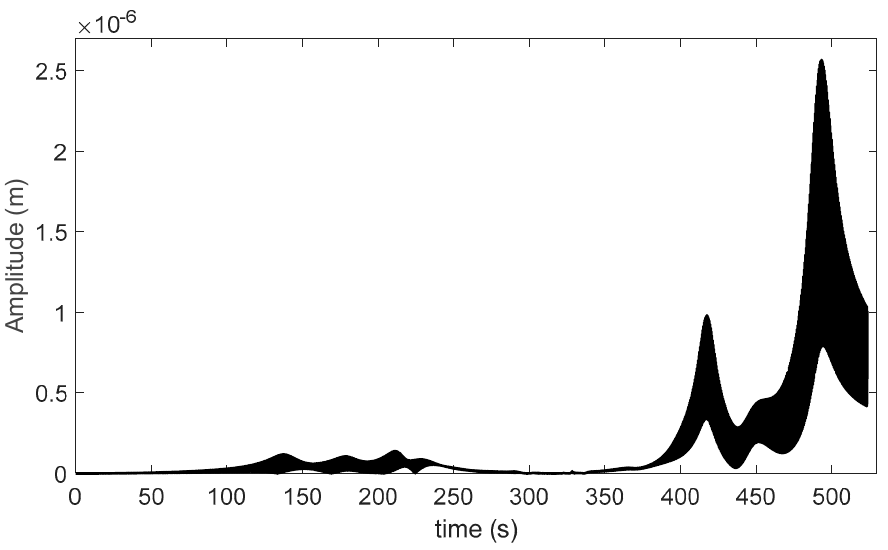
Figure 9. System vibratory response at node 4 with a linear ramp of excitation of 10 rad / s 2 .